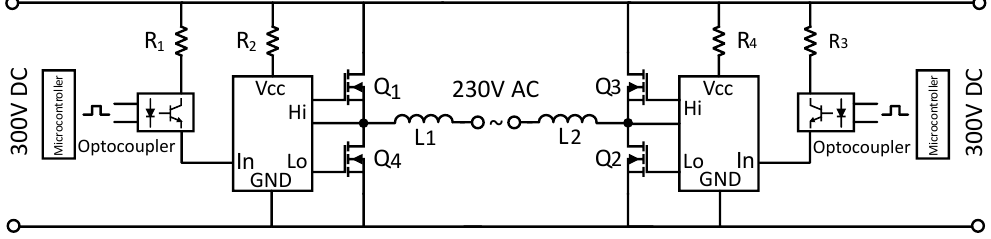
Figure 3. The schematic of the full bridge inverter.